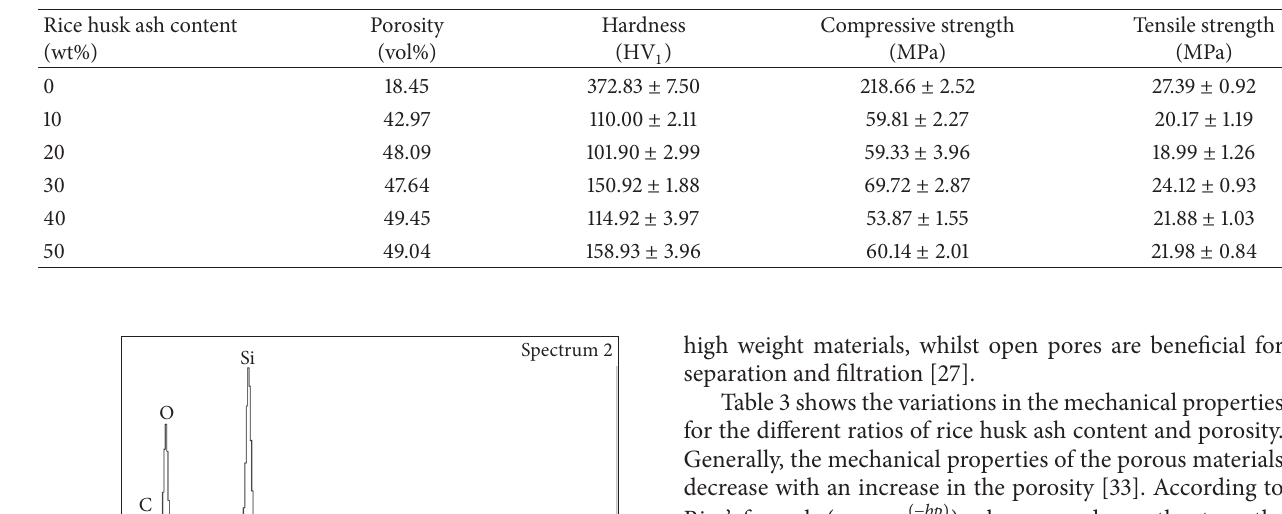
Table 3: Mechanical properties of porous ceramics.